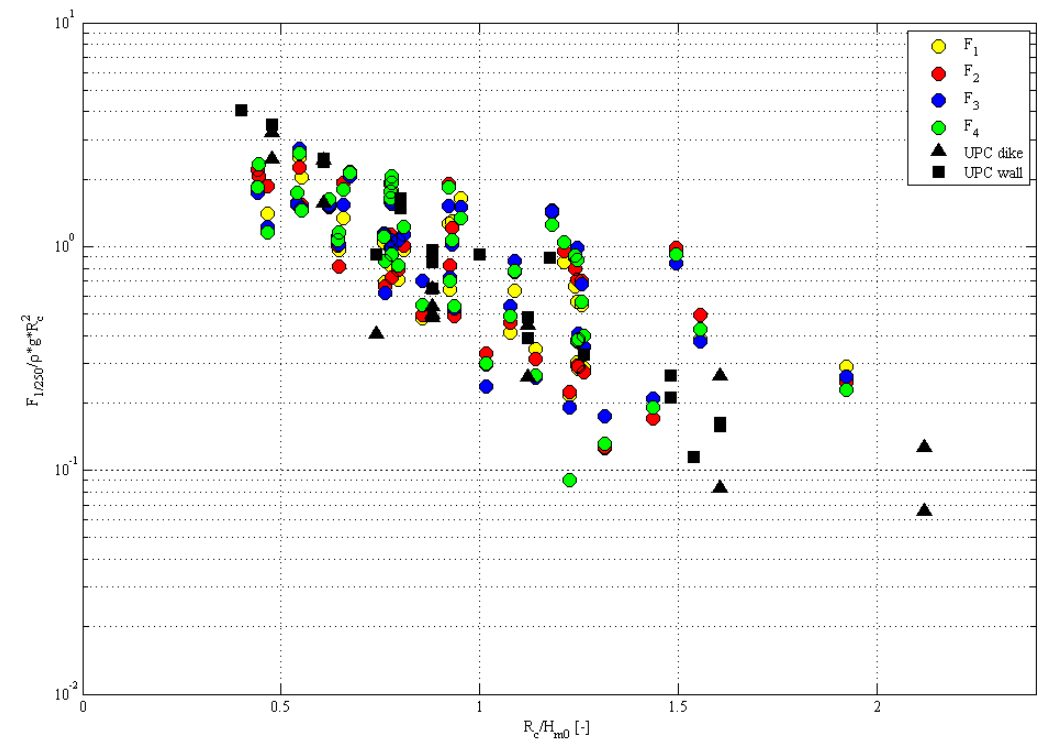
Figure 19. Dependence of the non-dimensional wave forces on the relative freeboard and comparison with data from UPC [10] .